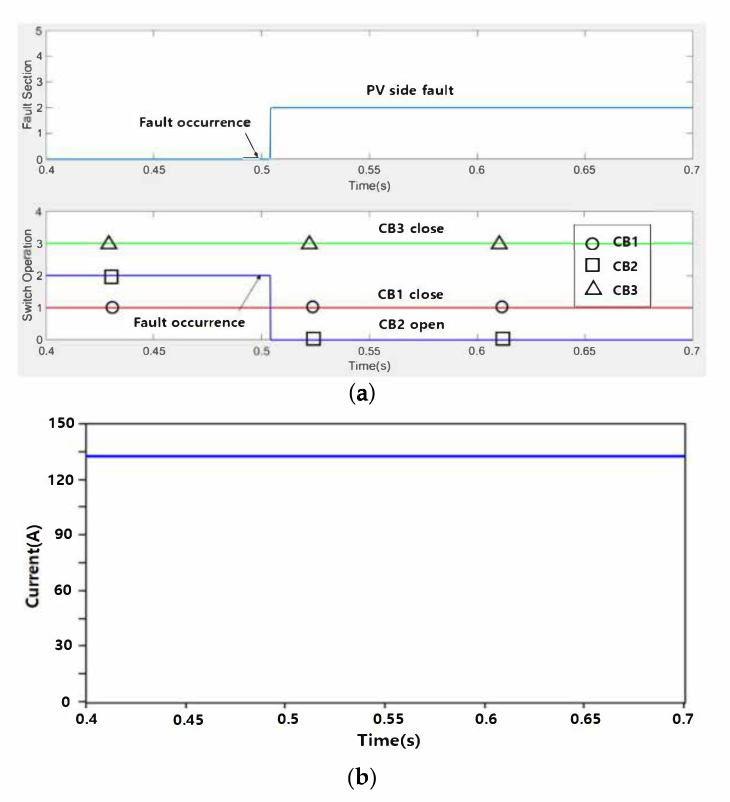
Figure 22. Simulation results of Case 8: ( a ) Fault section and CB operation and ( b ) Load current.